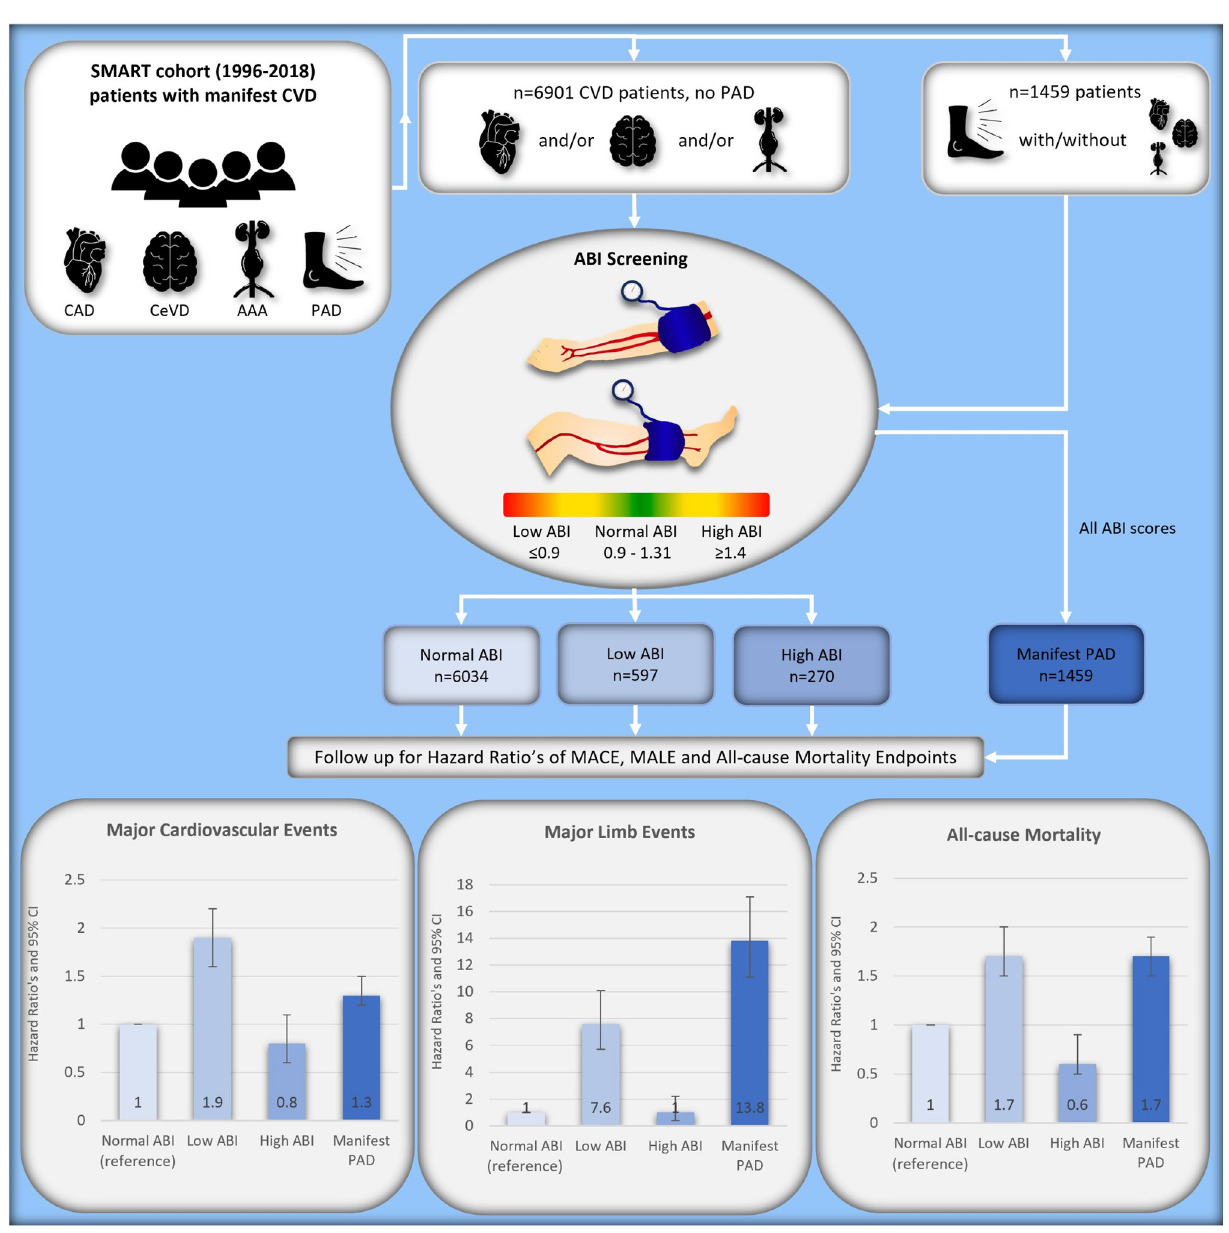
Fig 1. Graphical abstract: Screen-detected ABI scores as risk indicator for future CVD and mortality. Study population, methods, and results for the relationship between screen-detected ABI scores and future cardiovascular events, limb events and all-cause mortality in patients with manifest CVD. MACE was defined a composite of stroke, myocardial infarction, terminal heart failure, retinal infarction and/or hemorrhage and CVD death. MALE was defined as a composite of lower limb revascularization (thrombolysis, vascular surgery, or major amputations of the ankle or more proximal). Graphs show Hazard Ratios adjusted for age, sex, smoking, non-HDL cholesterol, systolic blood pressure, renal function, and diabetes mellitus status. Abbreviations: UCC-SMART = Utrecht Cardiovascular Cohort Second Manifestations of ARTerial disease, CVD = cardiovascular disease, DM = diabetes mellitus, CeVD = cerebrovascular artery disease, CAD = coronary artery disease, AAA = abdominal aortic aneurysm, PAD = peripheral arterial disease, ABI = ankle brachial index, MACE = Major Cardiovascular Adverse Events, MALE = Major Adverse Limb events. the legs while walking. Both symptomatic (but without known PAD before inclusion) and asymptomatic patients were included, as this accurately represents ABI screening in clinical practice.